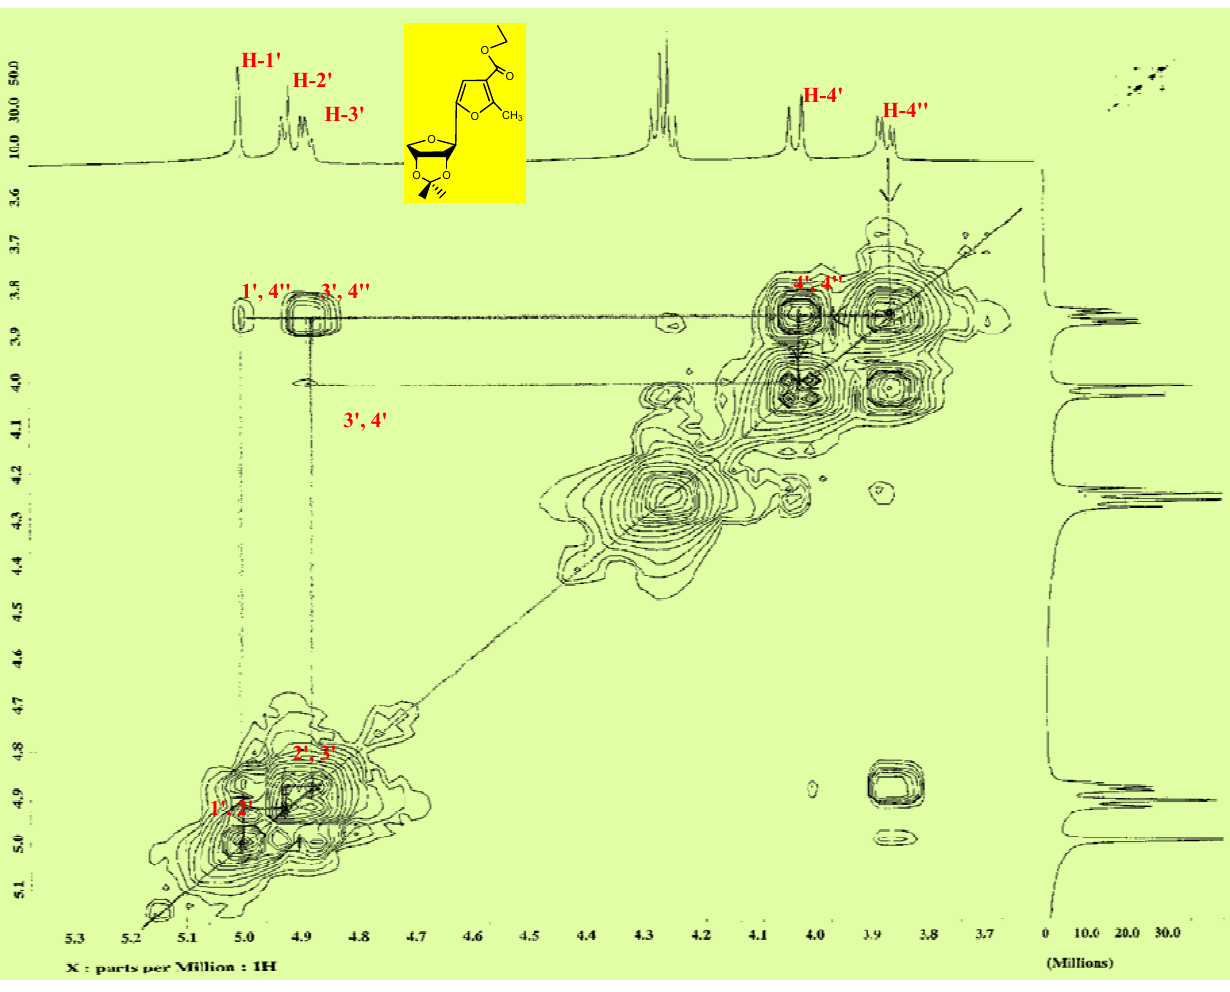
Figure 1. 2D 1 H-NMR spectrum of compound 3b